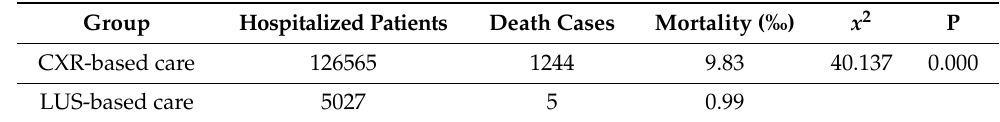
Table 6. The influence of LUS-based care on mortality of hospitalized patients.